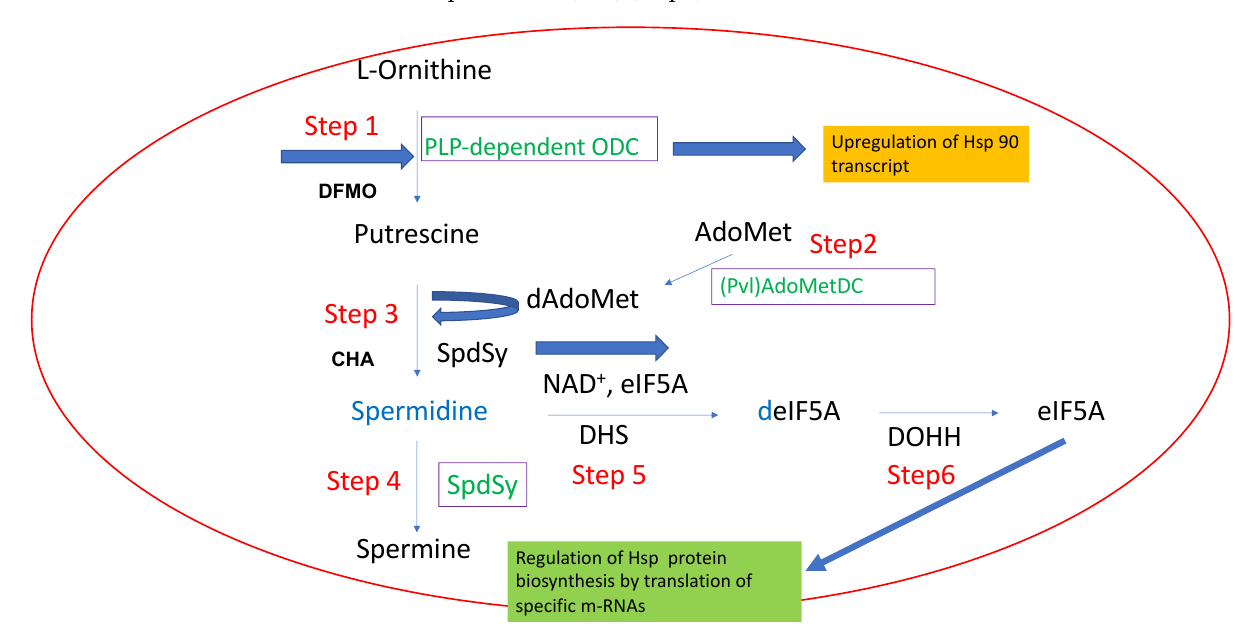
Figure 6. The polyamine pathway in Plasmodium species and its link to Hsps. Ornithine decarboxylase is involved in the upregulation of Hsp90 transcripts, while hypusinated eIF5A regulates the biosynthesis of Hsps.